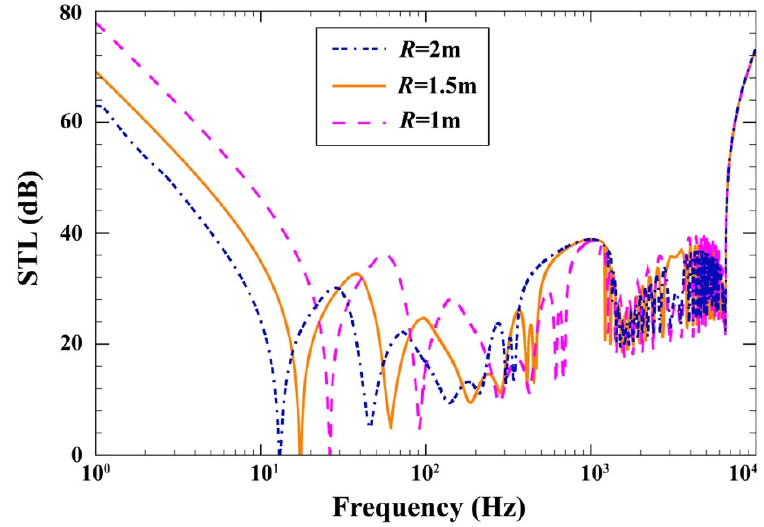
Figure 8. STL plots for different values of the average radius.